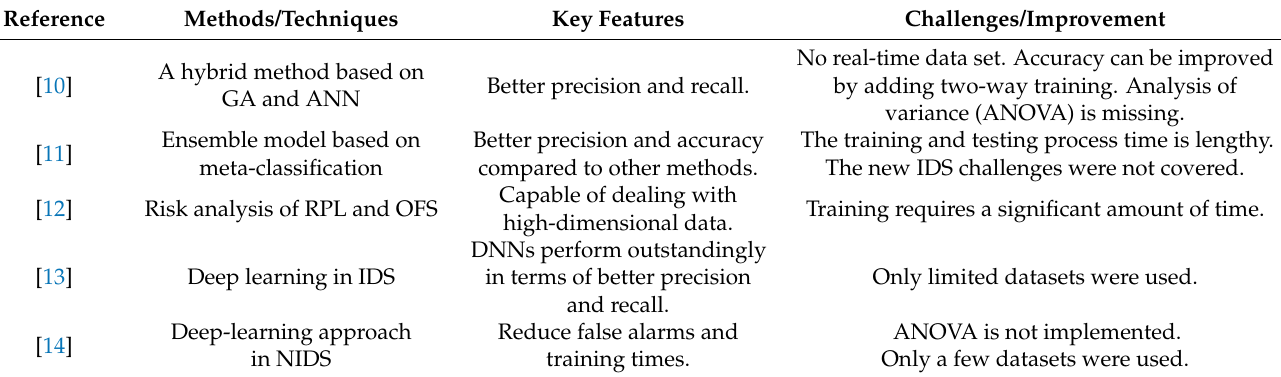
Table 1. Review of existing work in the field of intrusion